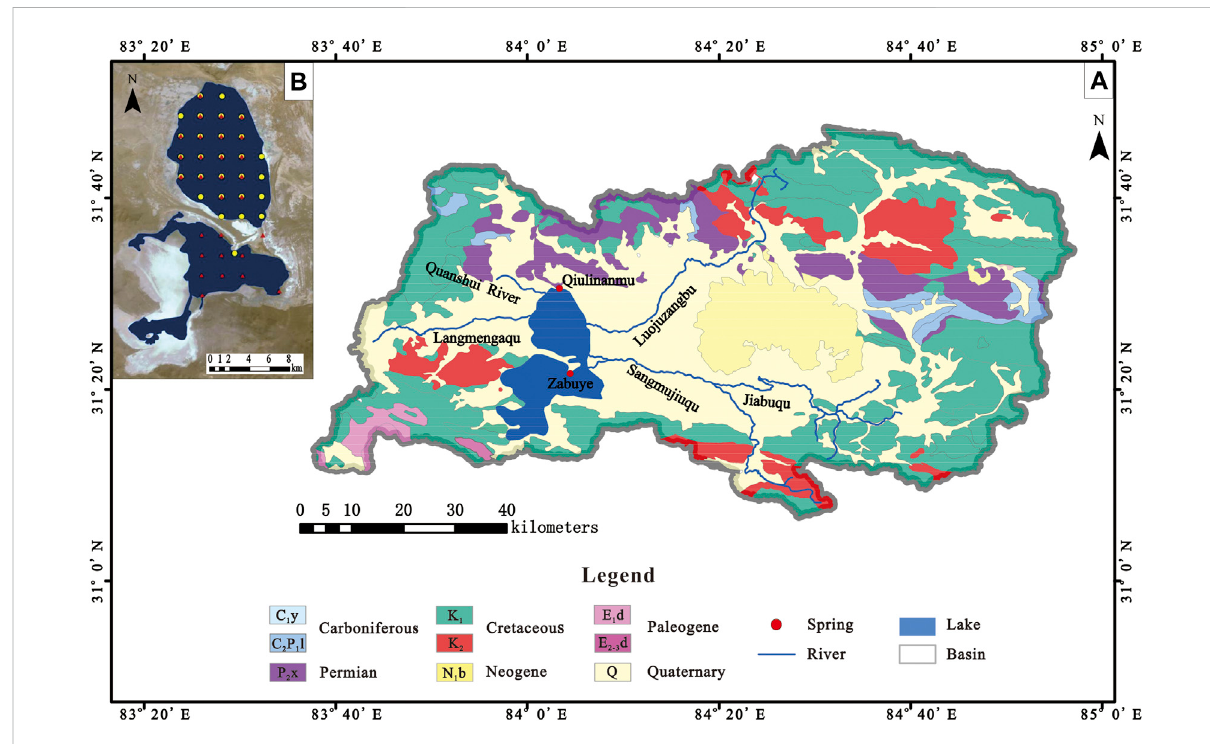
FIGURE 1 (A) Geological map of the Zabuye watershed. (B) Distribution map of sampling points (The red points are in 2000, and the yellow points are in